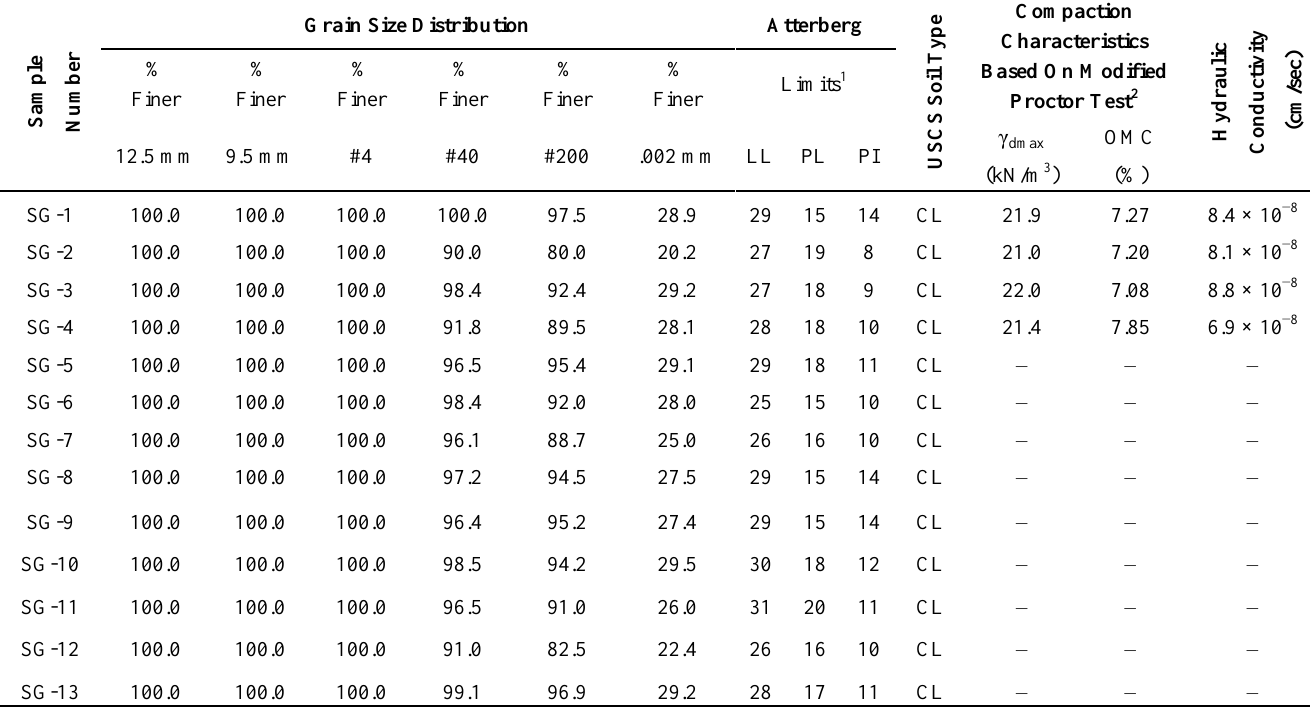
Table 3. Geotechnical characteristics of